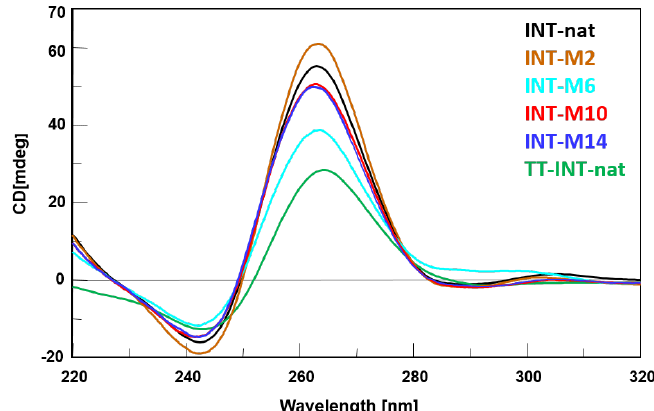
Figure 3. CD spectra of the T30923 analogues investigated. See Materials and Methods for experimental details.